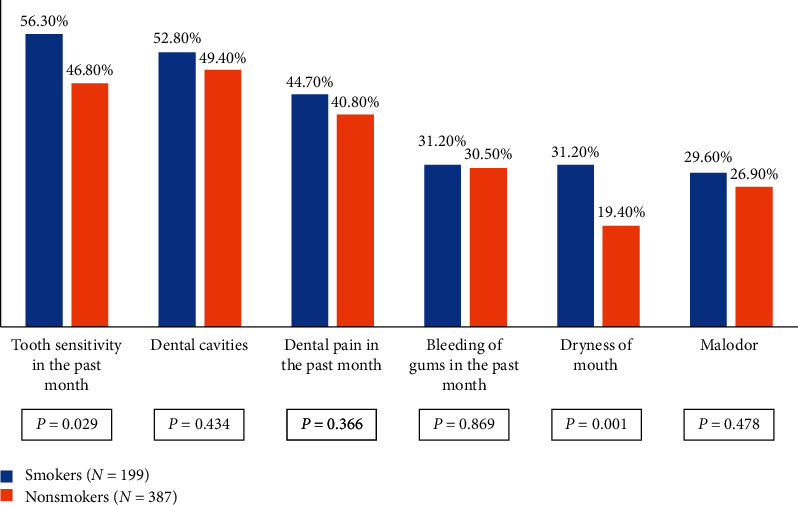
Comparison of self-reported oral problems between smoker and nonsmoker students.